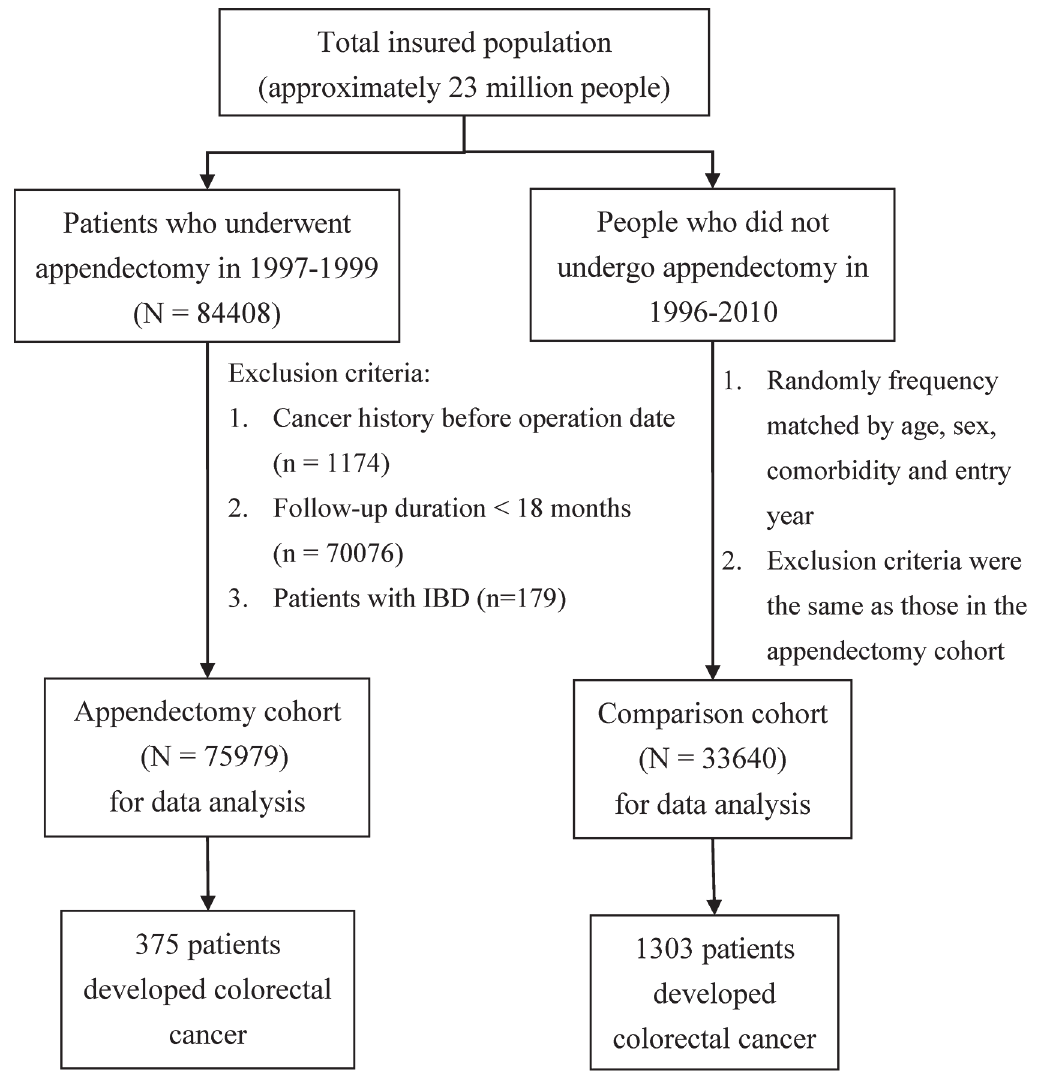
Fig 1. Flow chart for the study